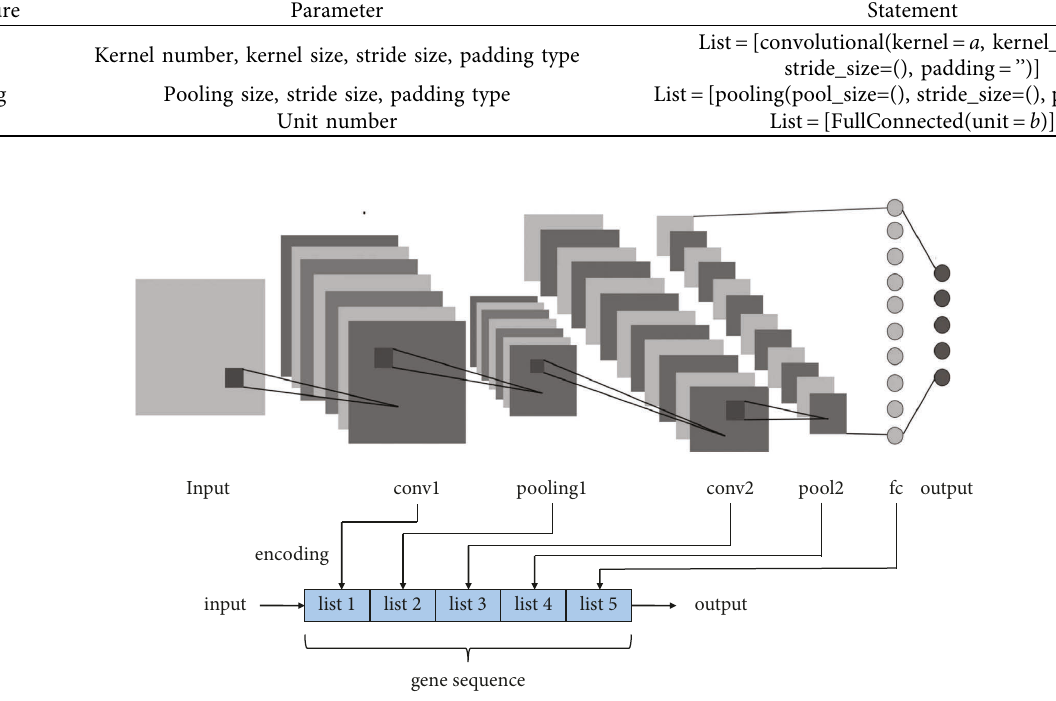
Figure 8: Schematic diagram of encoding of ECNN.